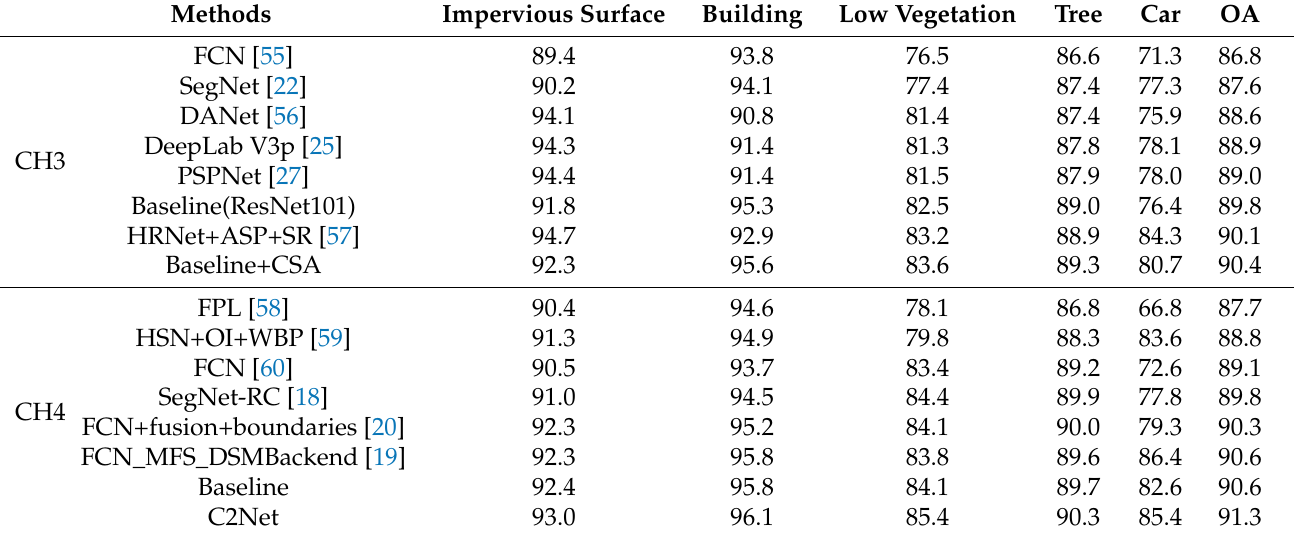
Table 4. State-of-the-art comparison experiments on ISPRS Vaihingen test